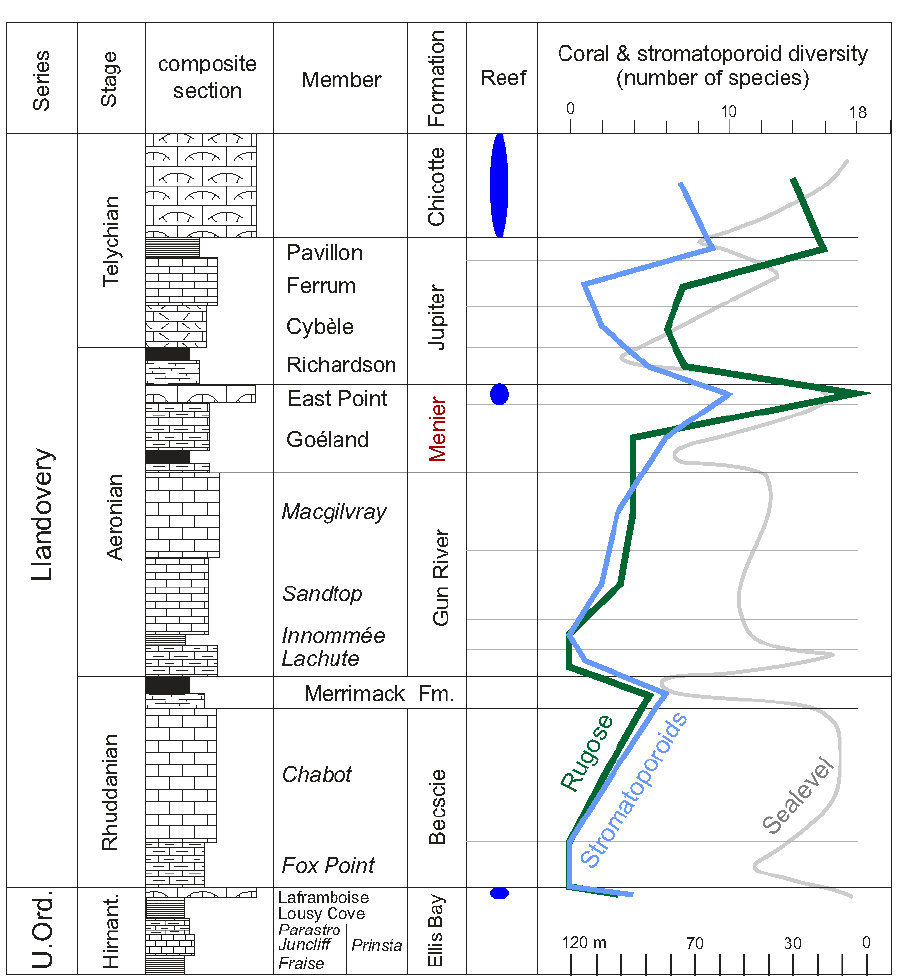
Figure 2. Stratigraphic column of the 400 m thick Lower Silurian strata on Anticosti Island, beginning at the top of the Hirnantian Ellis Bay Formation, and terminated by the Telychian Chicotte Formation. The Menier Formation comprises the two lower members of the original Jupiter Formation, i.e. , the Aeronian deeper shales and limestones of the Goéland Member and reefal-crinoidal carbonates of the East Point Member. Stromatoporoid diversity data from Nestor et al. [7], and coral data from McLean and Copper